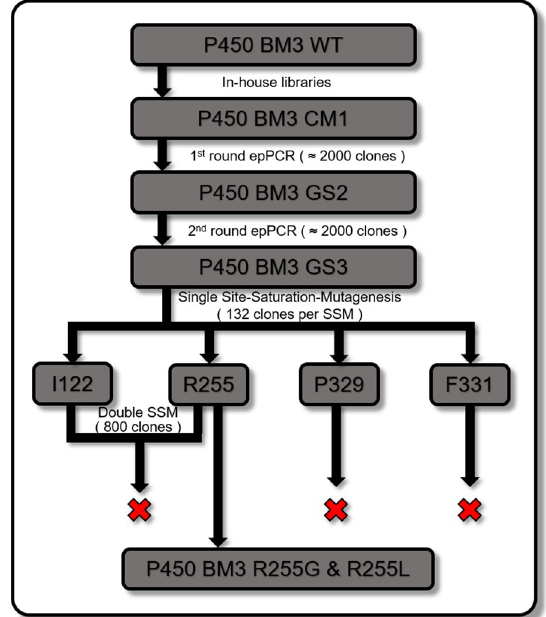
Figure 3. Summary of P450 BM3 engineering strategy. Starting from the top to the bottom,